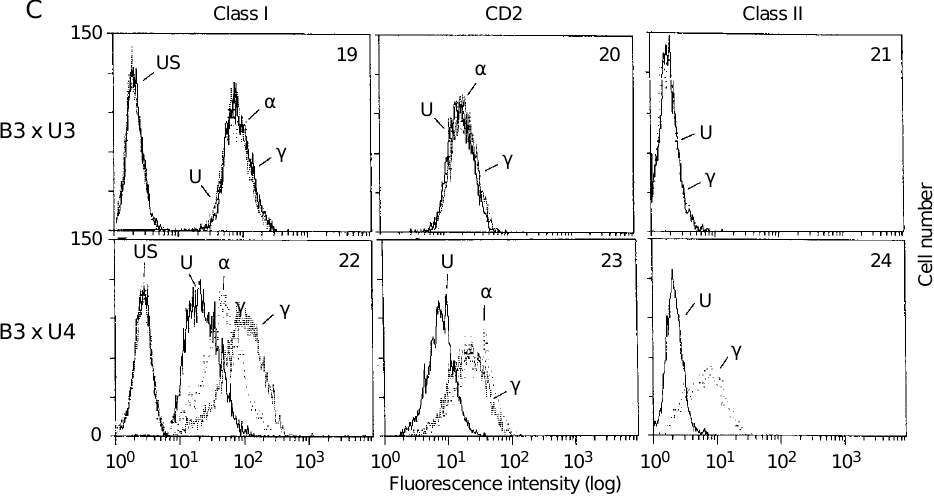
Figure 2 - IFN-stimulated gene expression in the parental cell line 2C4, in the B9 mutant and in the hybrid cells B9 x U3. The expression of 2'-5' OAS, 9-27, and GBP mRNAs in the parental cell line 2C4 (lanes 1-3), in the B9 mutant (lanes 3-6) and in the hybrid cells B9 x U3 (lanes 7-9) was investigated. Cells were left untreated (lanes 1,4,7) or treated with IFN- a (lanes 2,5,8) or IFN- g (lanes 3,6,9), respec- tively. Cells were incubated with 500 IU/ml of either IFN- a or IFN- g for 6 h and 18 h, respectively. Cytoplasmic RNA was isolated (10 µg per lane), hybridized with the specific probe as indicated on the left, and analyzed by the RNase protection assay as de- scribed in Material and Meth- ods. g -Actin was used as an in- ternal standard for